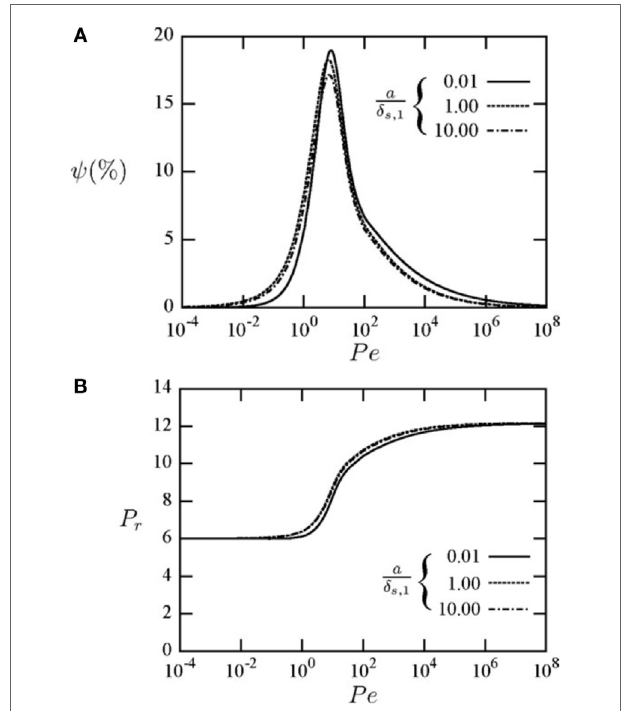
FiGURe 11 | (A) Thermodynamic loss due to finite unsteady heat transfer, ψ , and (B) pressure ratio, in a reciprocating gas spring with a volumetric compression ratio of six, a (solid-to-fluid) thermal conductivity ratio of 1.06, density ratio of 145.1 and specific heat capacity ratio of 0.15, and for different normalized cylinder wall thicknesses, a / δ as shown in the legend, as a function of Péclet number, Pe. Reproduced with permission from Mathie et al.